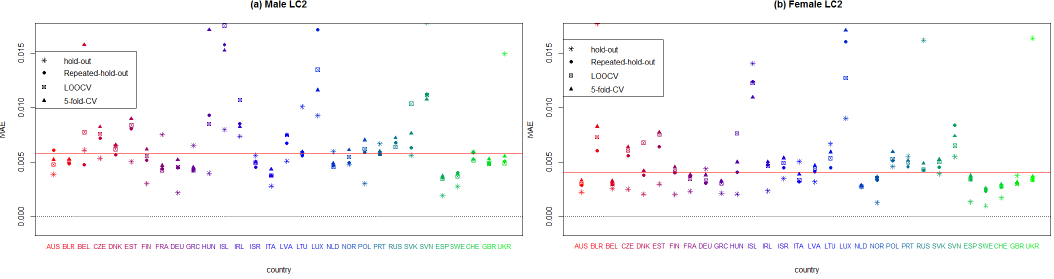
Figure A4. Plot summarizing the mean absolute measure (MAE) of each European country that applies bifactorial Lee–Carter model to males and females, according to every employed resampling method.